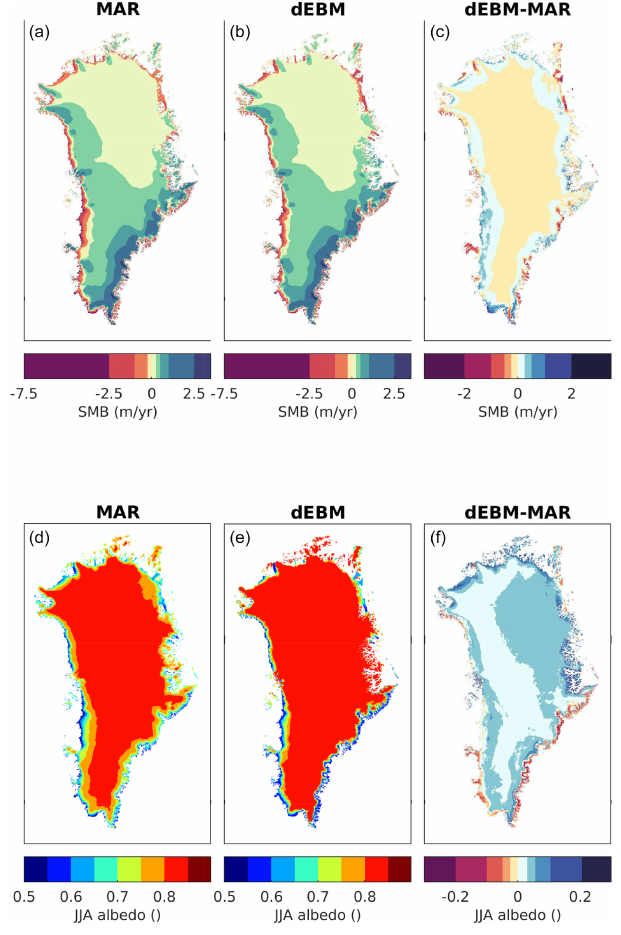
Figure 10. Comparison of multi-year (1980–1999) mean surface mass balance (a, b, c) and summer albedo (d, e, f) from experiments MAR ERA (a, d) and dEBM MAR , ERA (b, e) and differences between dEBM MAR , ERA and MAR ERA (c, f) .